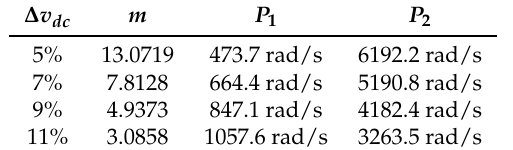
Table 1. Poles for the simulation of G dc ( s ) presented in Figure 10.